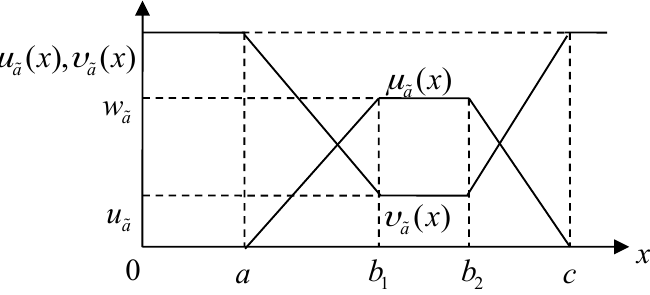
> . , u (cid:101) a (cid:101) a